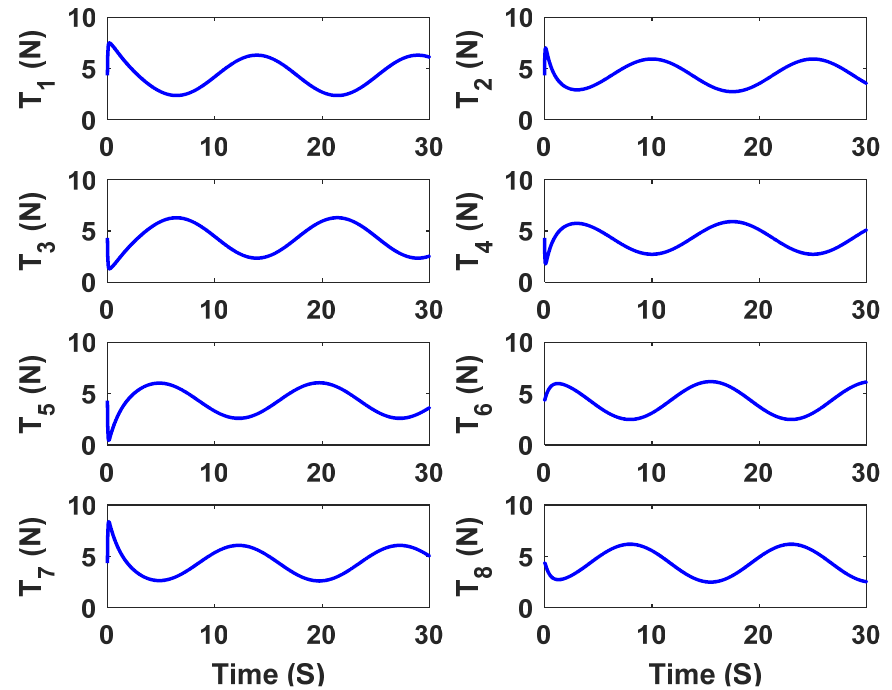
Figure 7. UAV motors thrusts in the first control case.